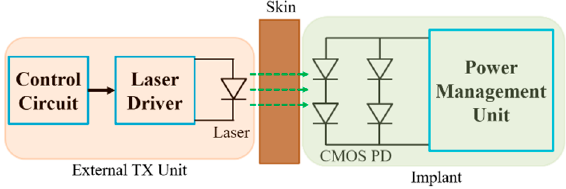
Figure 51. Complete optical power transfer (OPT) system.